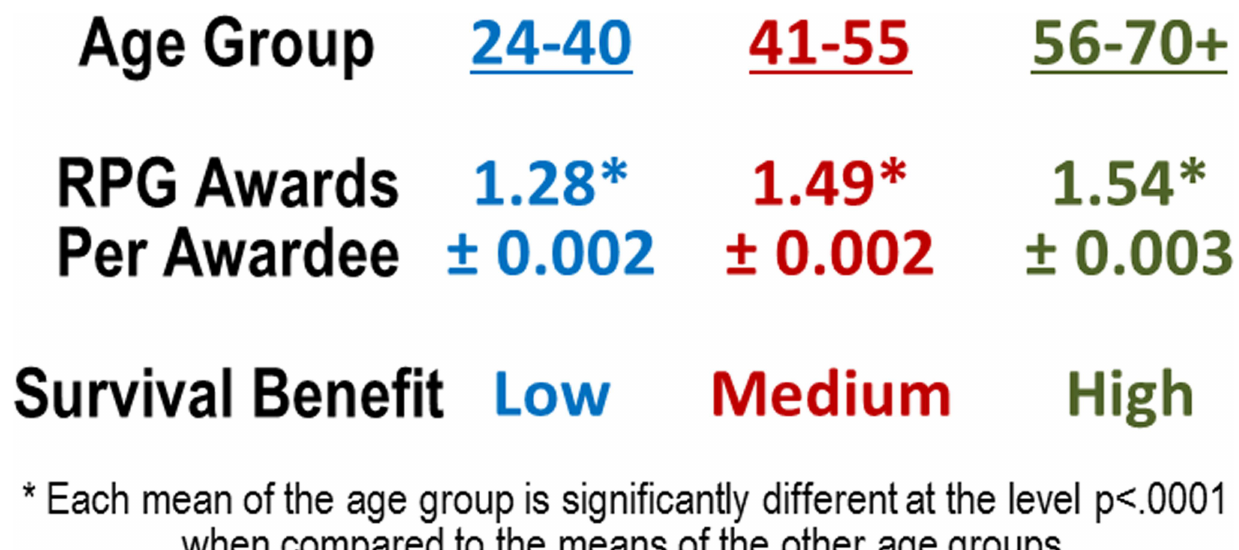
Fig 6. Gradient of Multi-Grant Associated Survival Benefit. The aggregateaveragenumber of the total NIH RPG awards per awardeeby age group plus or minus the standard error of the mean duringthe periodof 1998 through 2014.